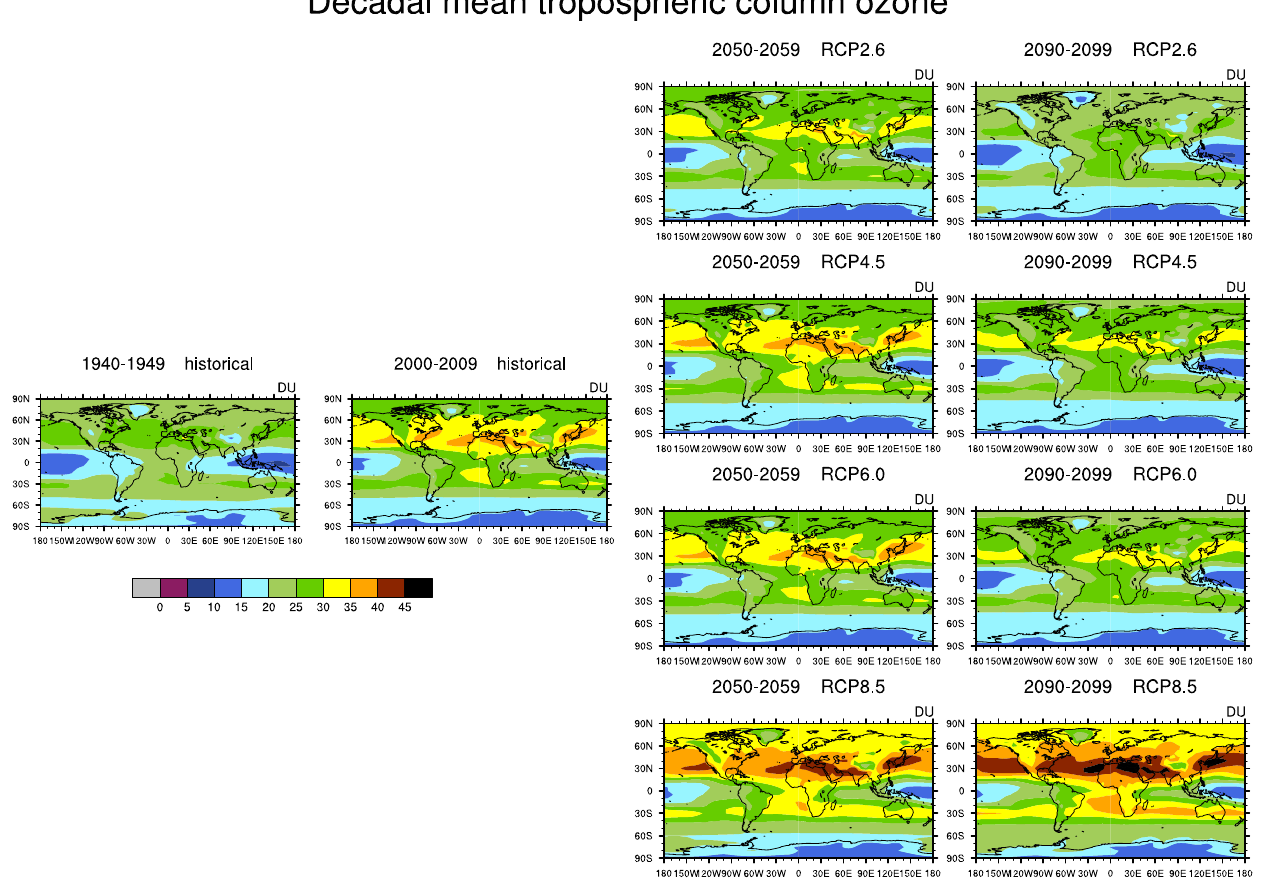
Fig. 9. Decadal mean tropospheric column in the historical database (left for the 1940s and 2000s) and the RCPs (right); from top to bottom: RCP 2.6, RCP 4.5, RCP 6.0 and RCP8.5 shown for the 2050s and